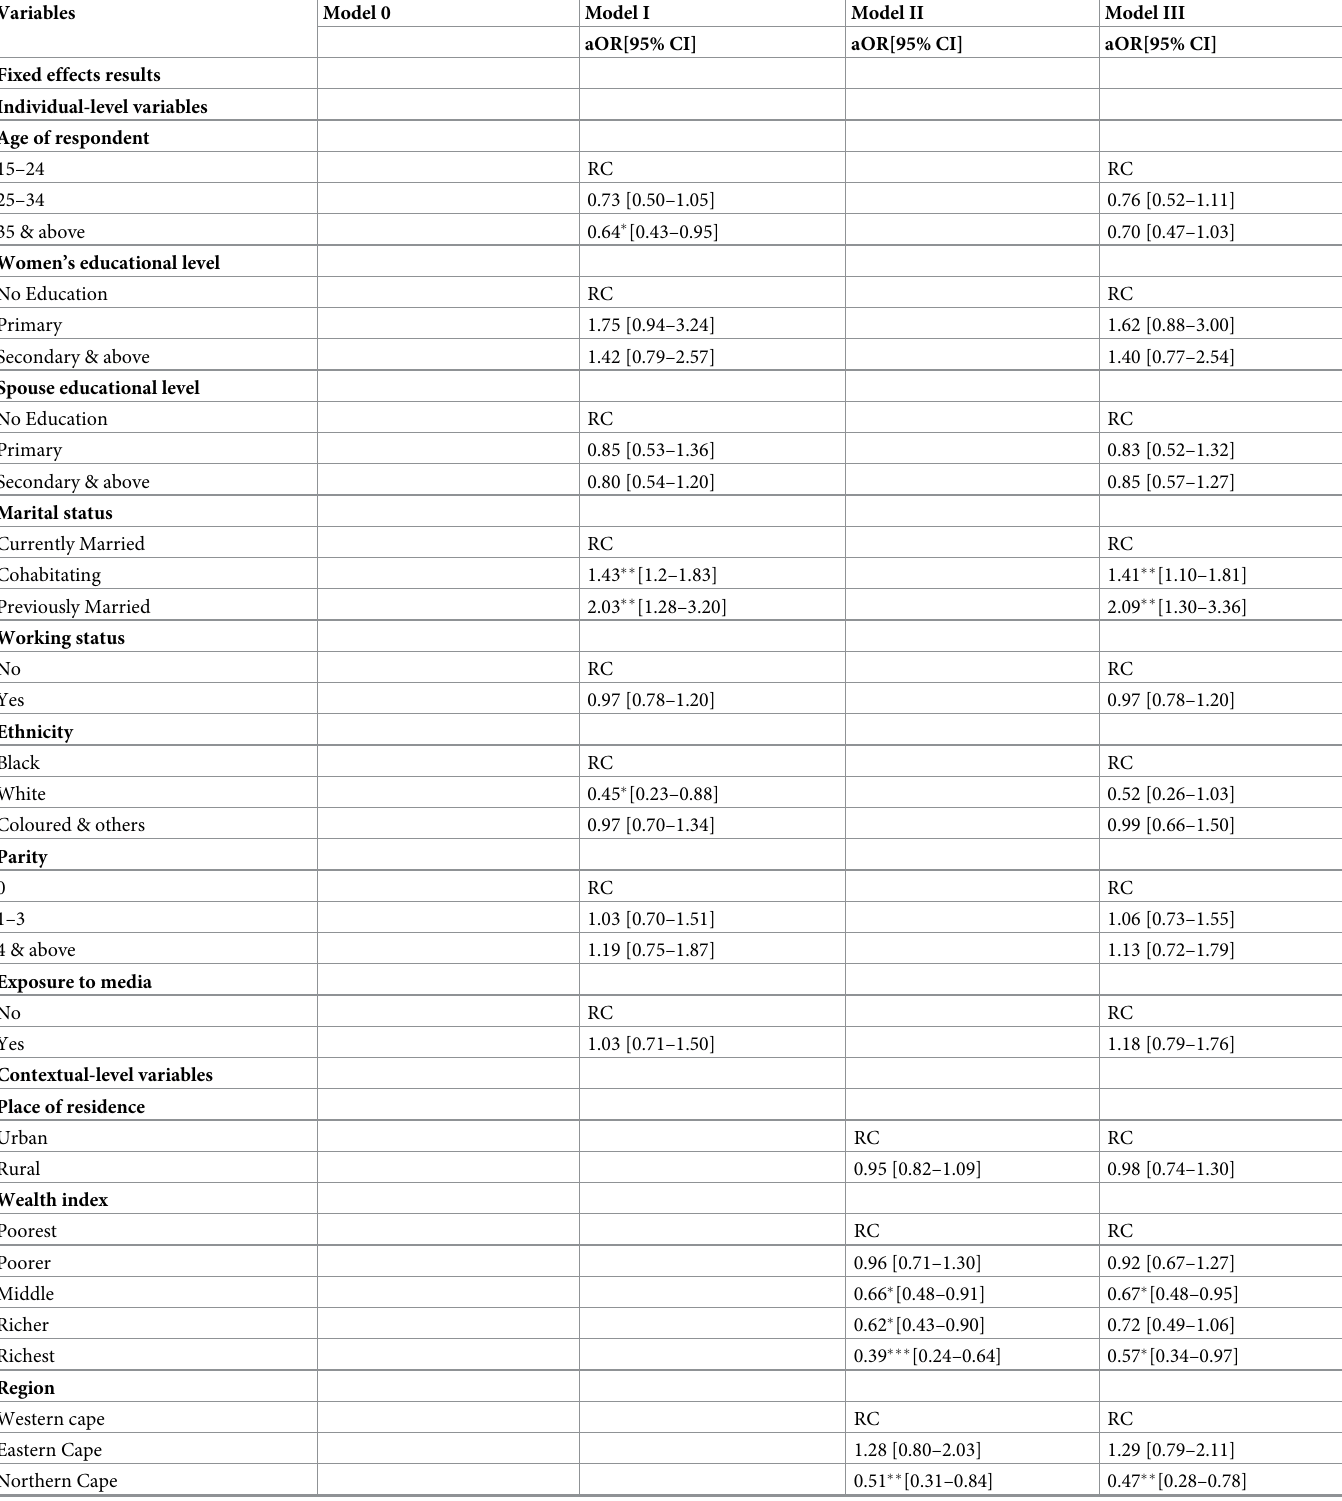
Table 2. Multilevel logistic regression models for individual and contextual level predictors of intimate partner violence in South